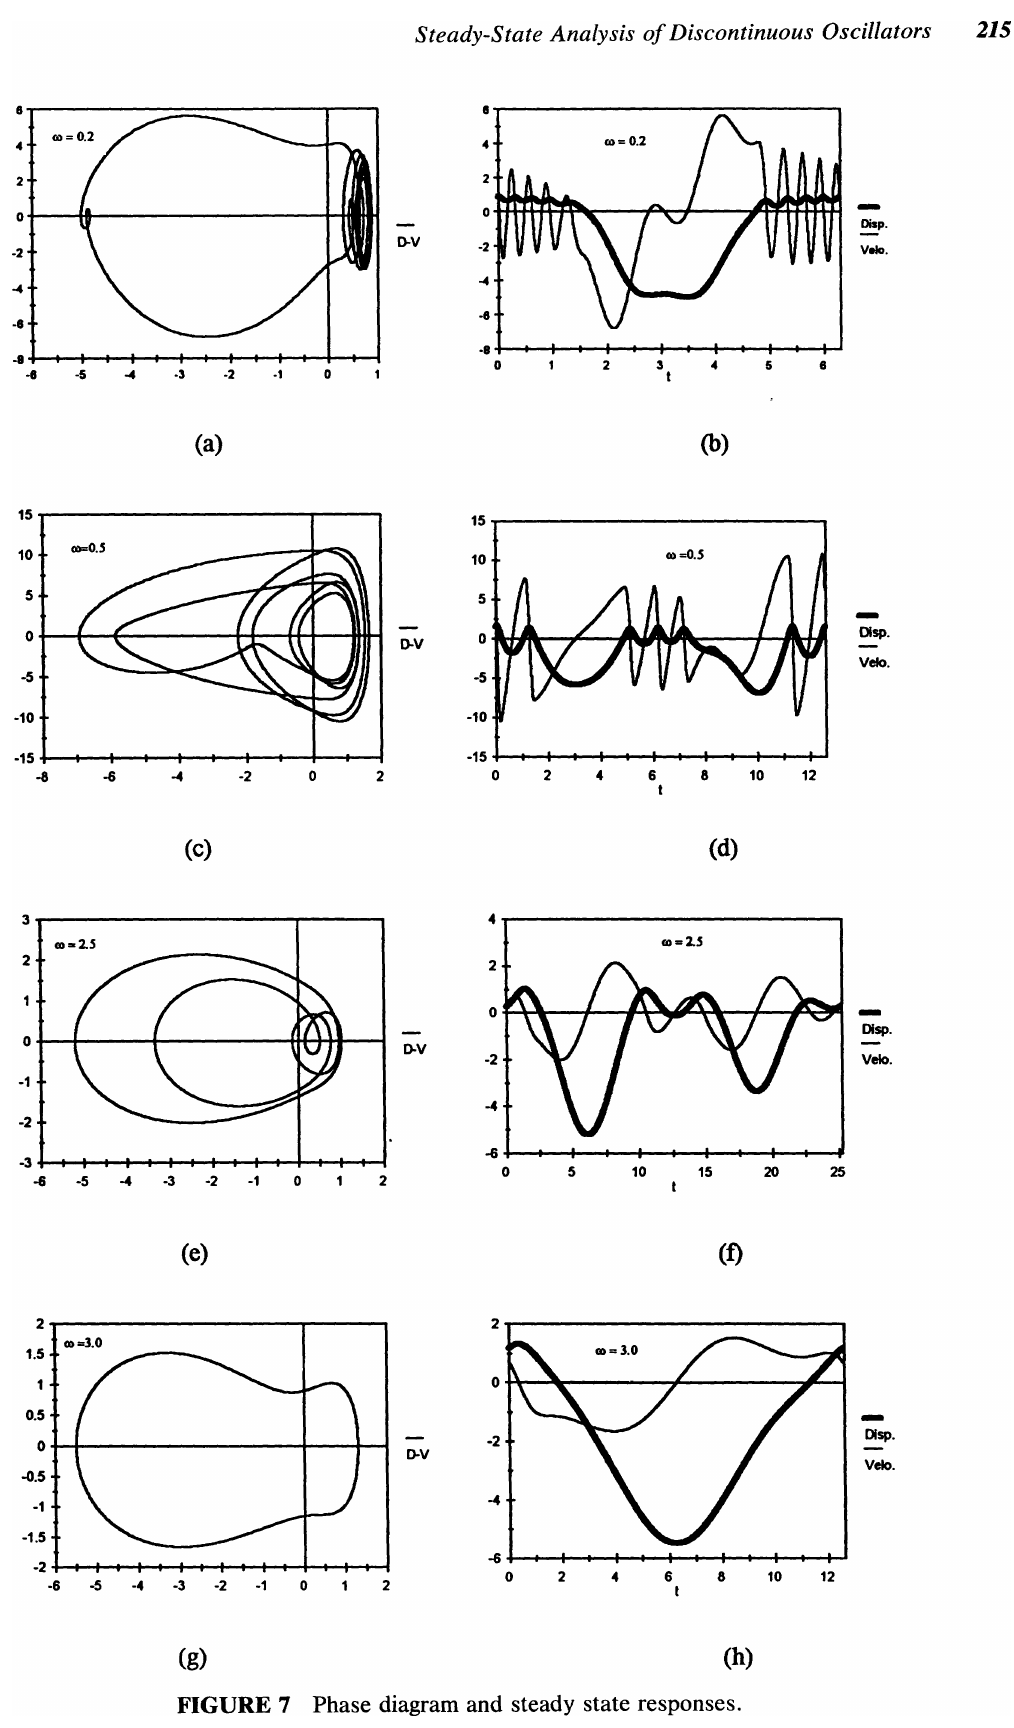
FIGURE 7 Phase diagram and steady state